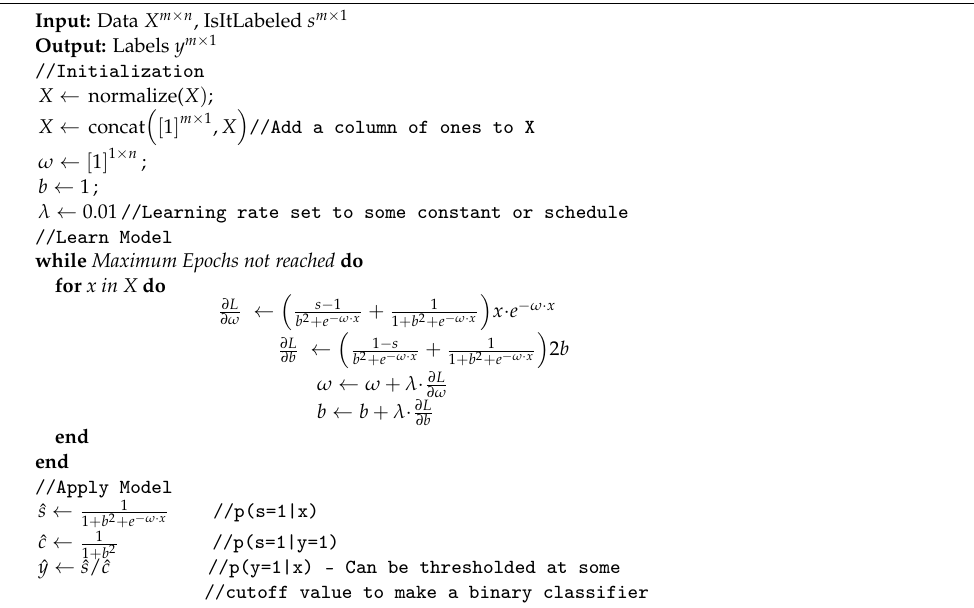
Algorithm A1 Modified Logistic Regression using Stochastic Gradient